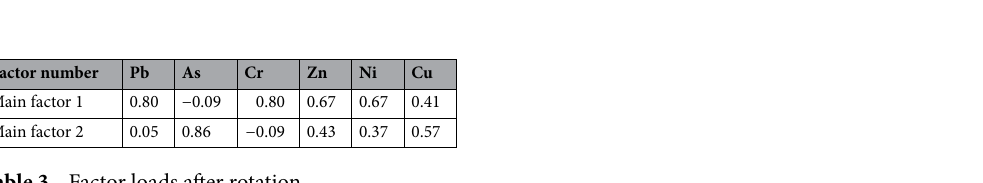
Table 3. Factor loads after